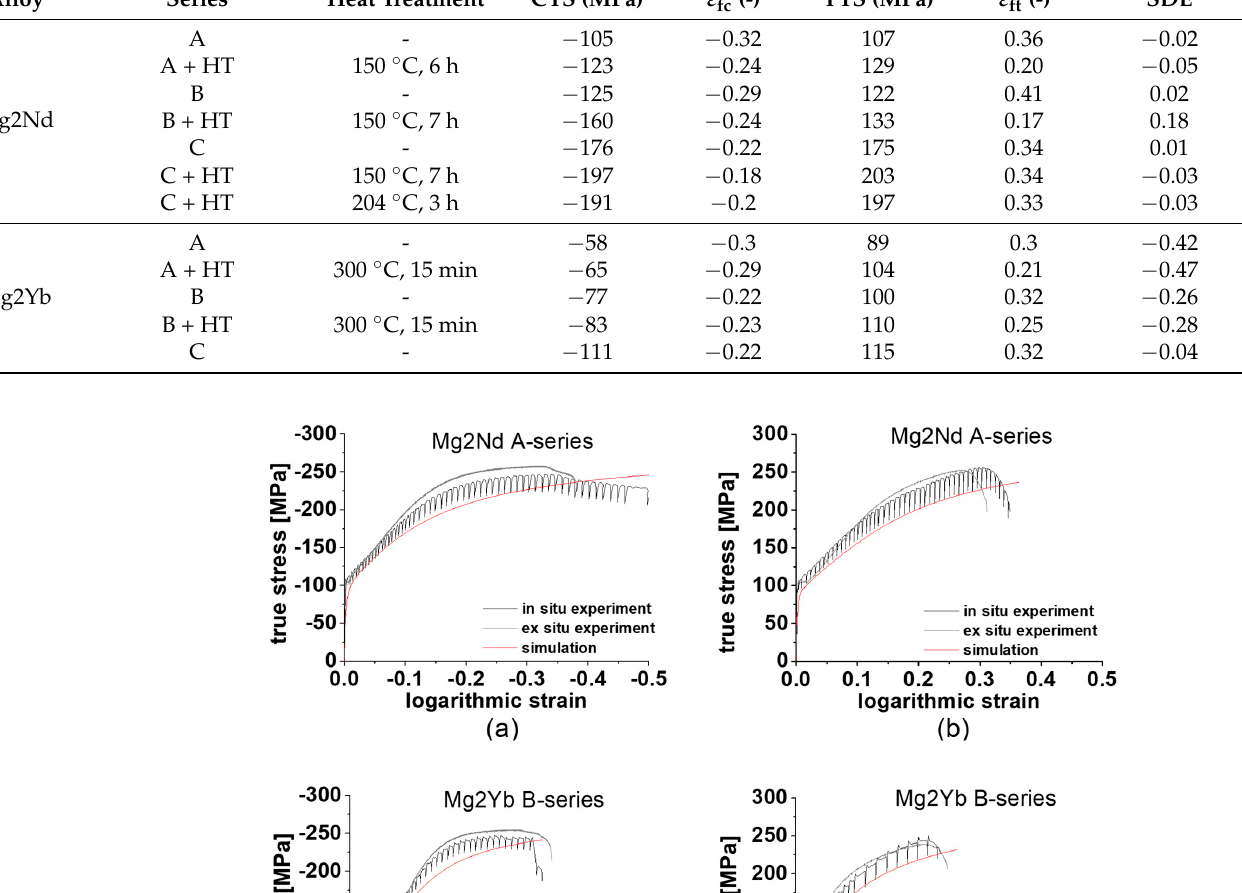
Table 2. Mechanical properties of the investigated alloys (the error of compressive yield strength (CYS) and tensile yield strength (TYS) is below 5 MPa, the error of ε fc and ε ft is below 0.02). Alloy